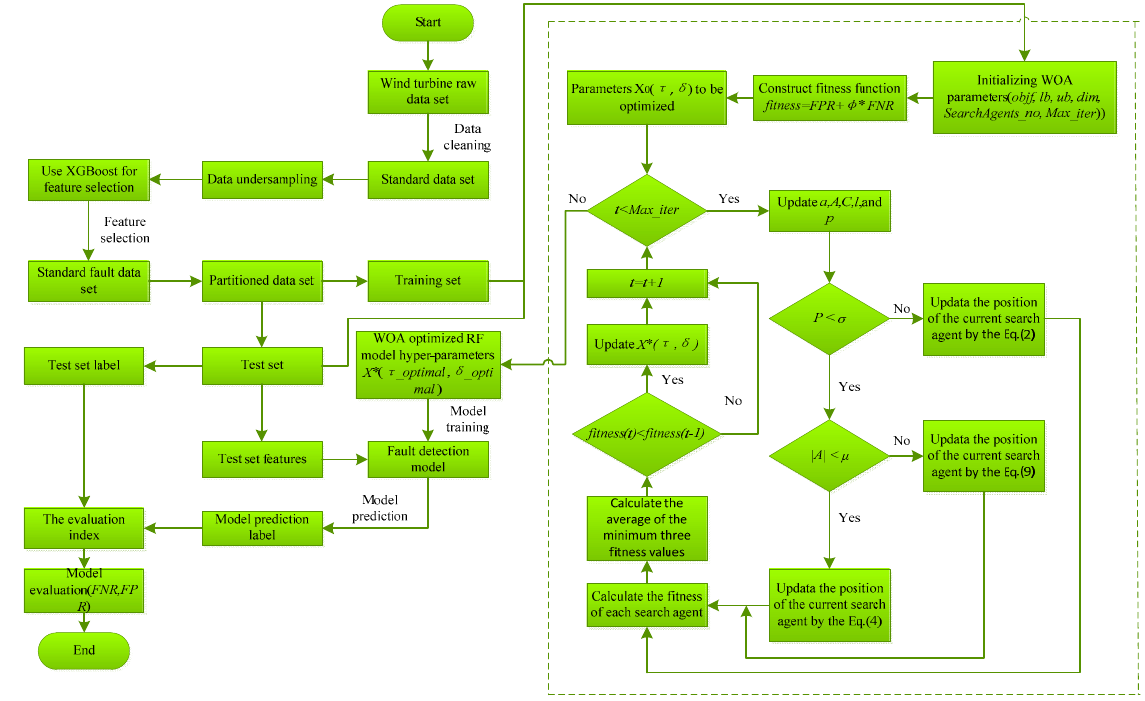
Figure 2. Gearbox fault diagnosis flowchart.